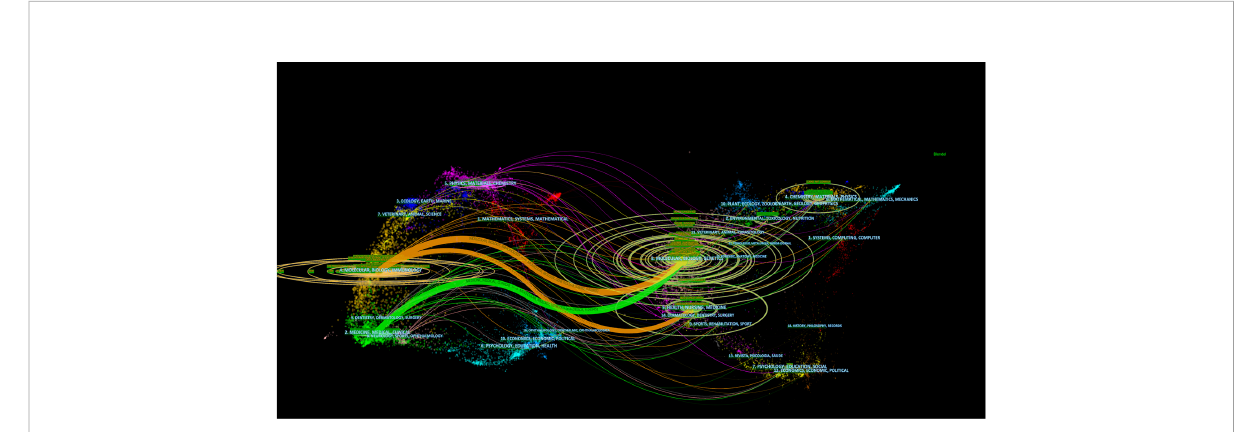
FIGURE 3 Dual-map overlay of periodicals associated with immunotherapy-TME studies. The citing journals are on the left, the cited journals are on the right, the labels represent the disciplines covered by the journals, and the colored path denotes citation association nations/regions and organization.